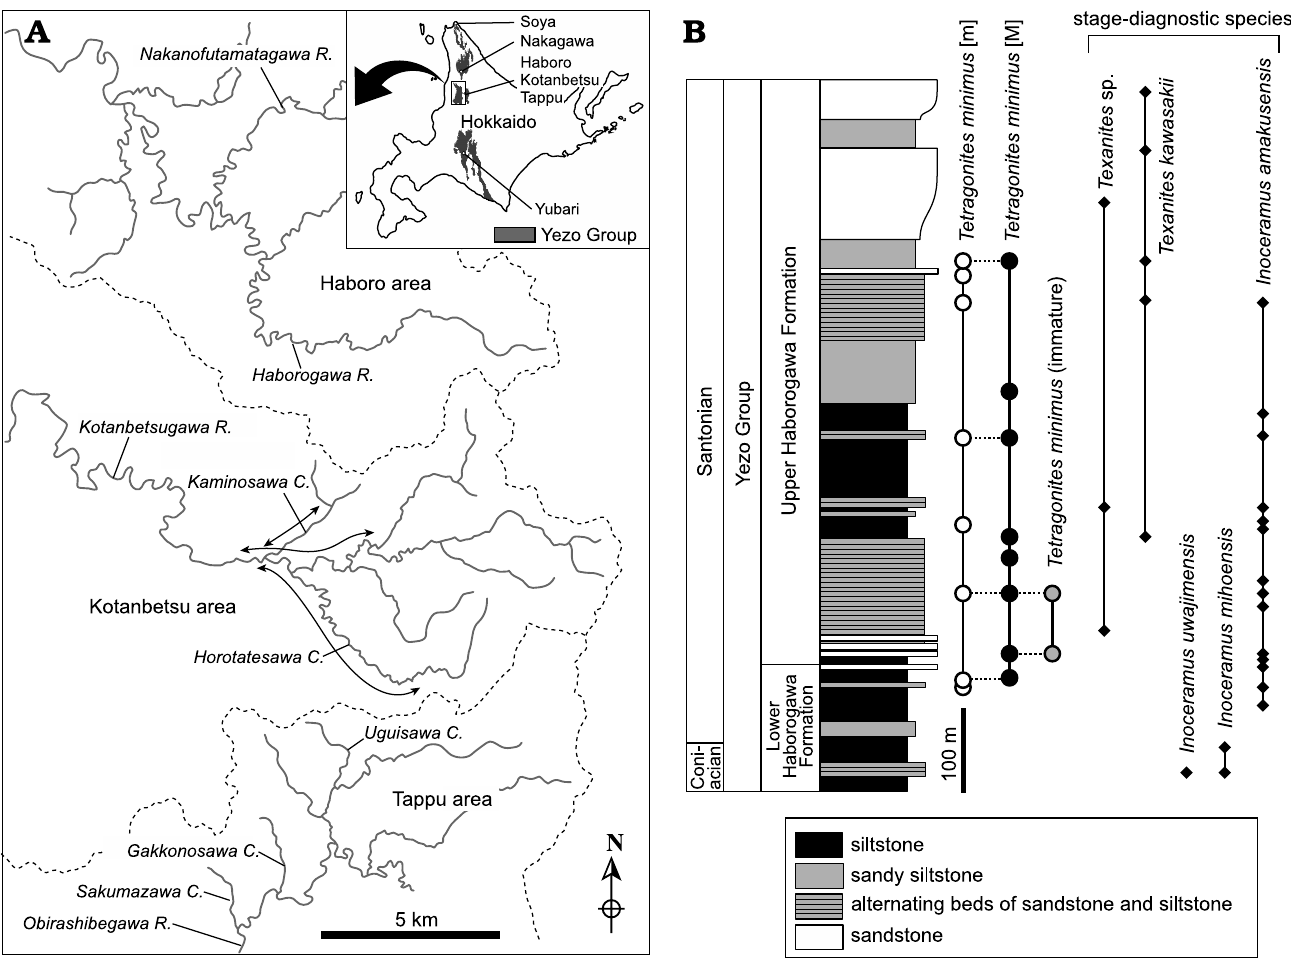
Fig. 1. A . Location map around studied areas in Hokkaido, Japan (inset shoving location of Yezo Group deposits). B . Generalized columnar section of the Santonian, Yezo Group in the Kotanbetsu area showing stratigraphic occurrence of dimorphic pairs of Tetragonites minimu s Shigeta, 1989, and the selected stage-diagnostic mega-fossils. Double head arrows indicate the areas where the columnar sections were constructed. See Aiba (2019) for details of stratigraphy. Abbreviations: C., Creek; R.,